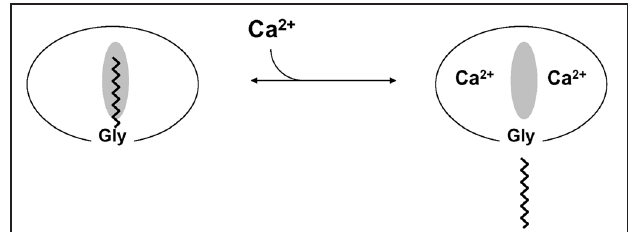
FIGURE 3 | Three-dimensional structures of myristoylated recoverin with 0 Ca 2 + bound (A), 1 Ca 2 + bound (B), and 2 Ca 2 + bound (C). The first step of the mechanism involves the binding of Ca 2 + to EF-3 that causes minor structural changes within the EF-hand that sterically promote a 45 ◦ swiveling of the two domains, resulting in a partial unclamping of the myristoyl group and a dramatic rearrangement at the domain interface. The resulting altered interaction between EF-2 and EF-3 facilitates the binding of a second Ca 2 + to the protein at EF-2 in the second step, which causes structural changes within the N-terminal domain that directly lead to the ejection of the fatty acyl